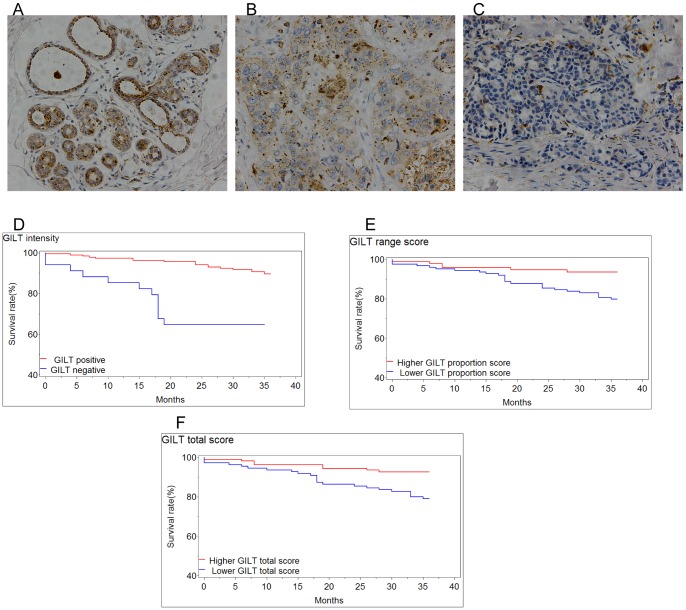
Expression of GILT and survival analysis in breast cancer.(A–C) GILT expression in breast tissues (original magnification, ×200). (A) Representative positive staining of GILT in normal breast tissue. (B) Representative positive staining of GILT in breast cancer tissues. (C) Representative negative staining of GILT in breast cancer tissues. (D–F) The expression status of GILT in breast cancer tissues were correlated with DFS by Kaplan–Meier estimates. (D) Decreased DFS time was observed in GILT negative patients (P<0.0001). (E) Decreased DFS time was observed in the lower GILT expression range score group (P = 0.0041). (F) Decreased DFS time was observed in the lower total GILT expression score group (P = 0.0041).